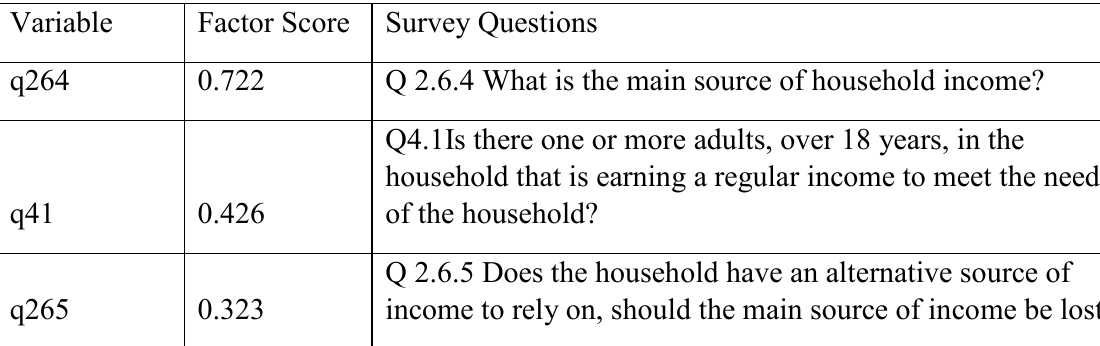
Table 1.38: Variables defining Adaptive Resilience PC8